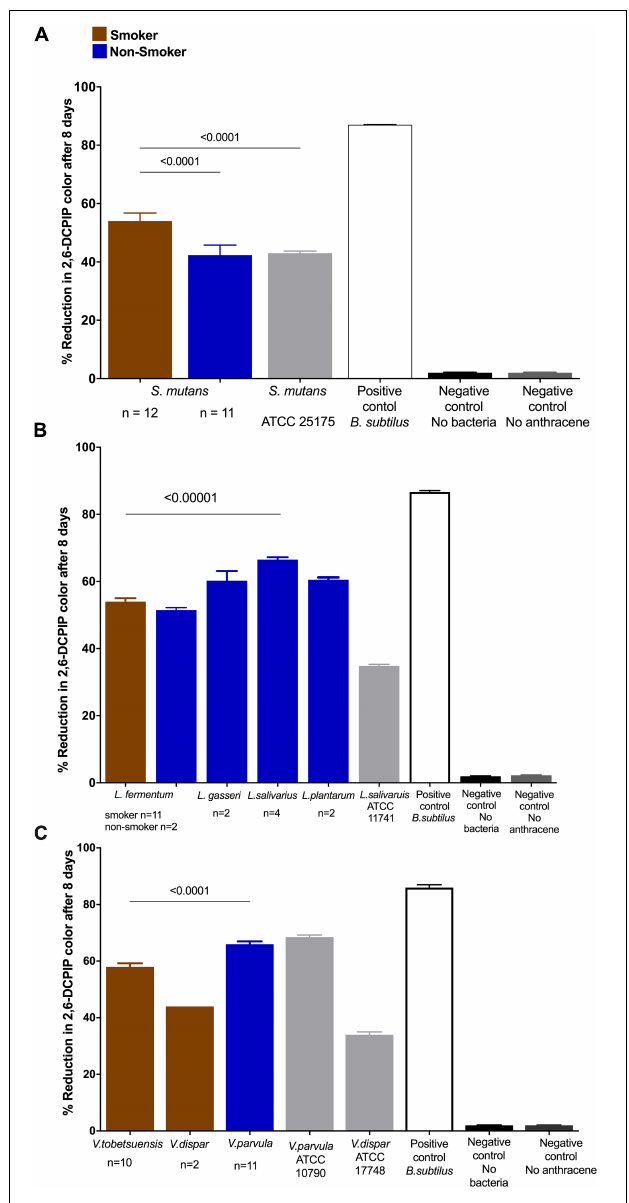
FIGURE 4 | Anthracene biodegradation after 8 days in smokers and non-smokers compared to standard strains, positive and negative controls. Biodegradation of anthracene by (A) S. mutans; (B) Lactobacillus spp.; and (C) Veillonella spp. represented as color intensity (%) of DCPIP. Statistical differences calculated using Mann-Whitney U -test followed by multiple comparisons using Holm Sidak’s corrections. Data presented as median ± interquartile range, where p < 0.05 was considered to be statistically significant. Bacillus subtilis (positive control one of the highest anthracene biodegrading microorganisms) and negative controls (no anthracene or no bacteria) were significantly different from the isolated species and ATCC strains. **** p <